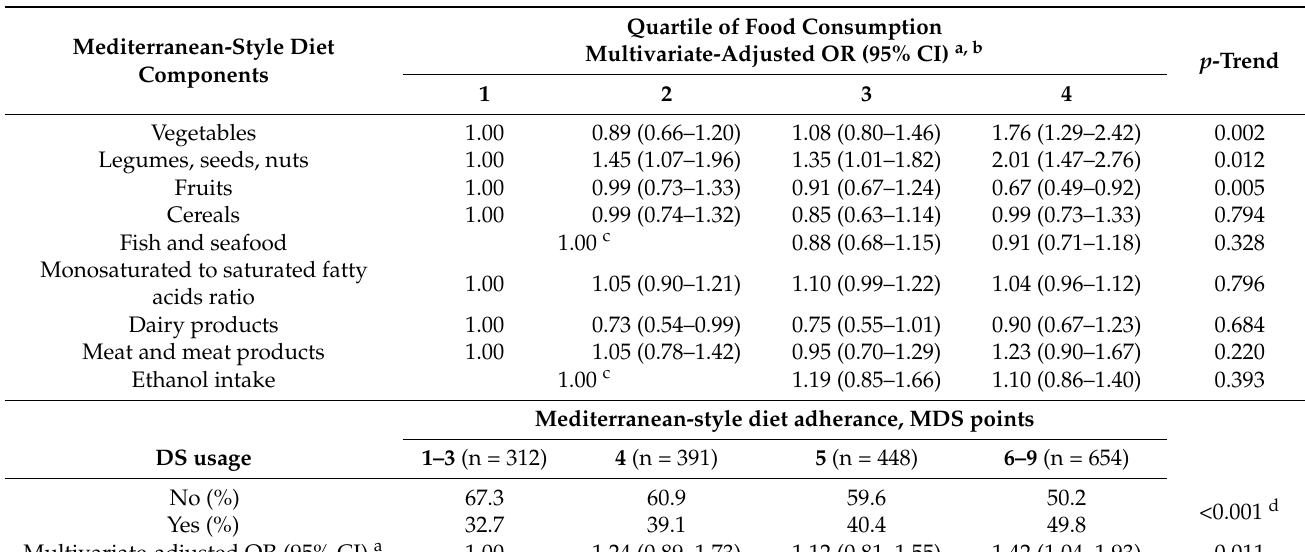
Table 5. The likelihood of using dietary supplements across quartiles of food consumption and the Mediterranean Diet Score (MDS) in university students (n =